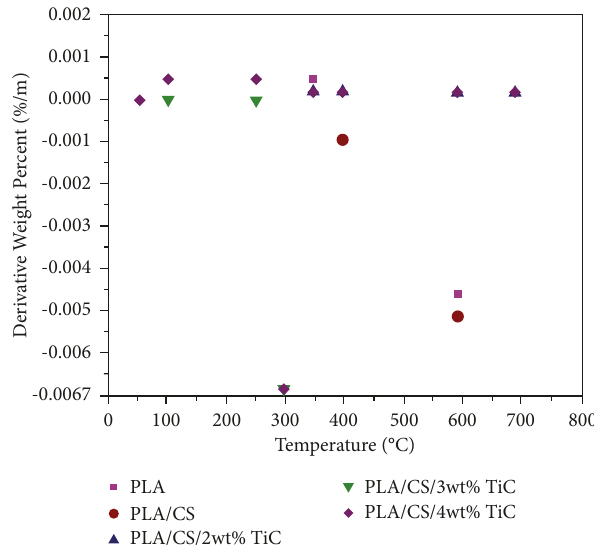
Figure 10: DTG thermograms of different composites.